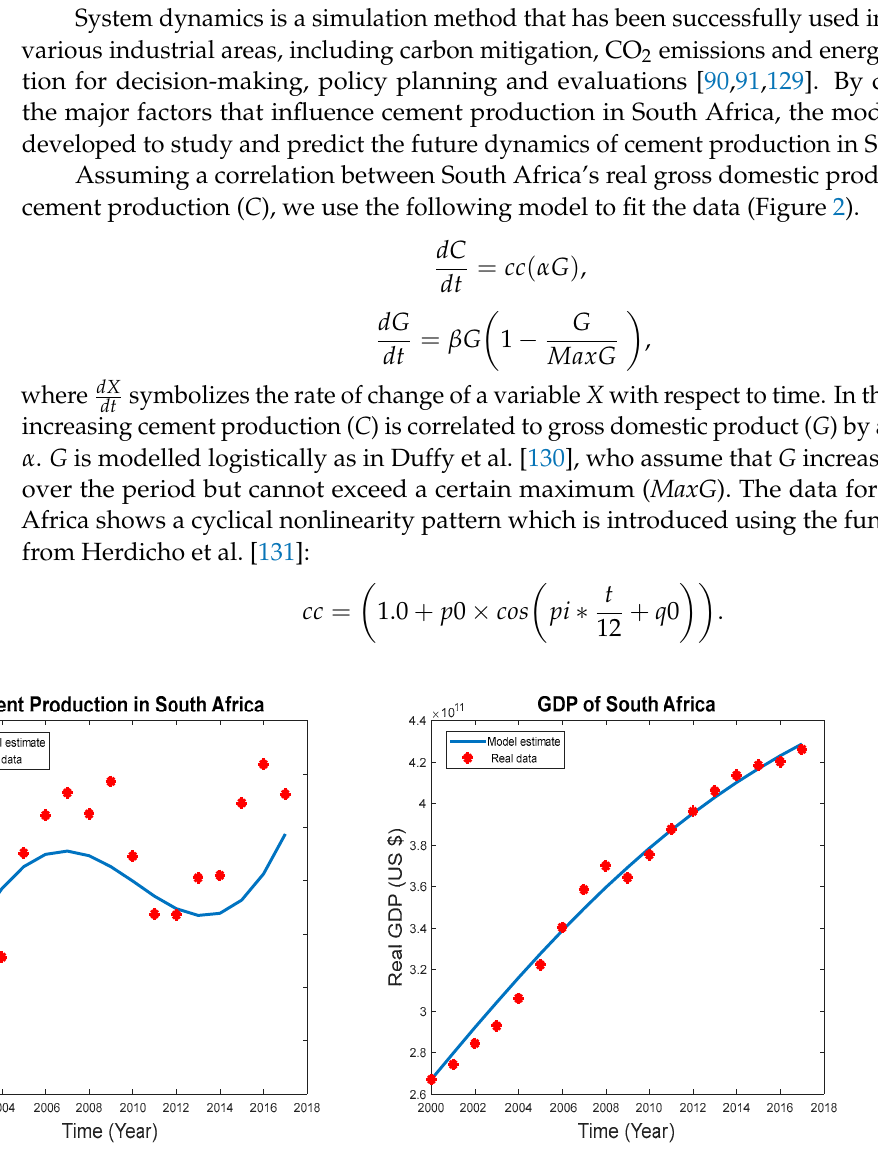
Figure 2. Plot showing the model fitting of cement production in South Africa and real GDP of South Africa from 2000 to 2017.